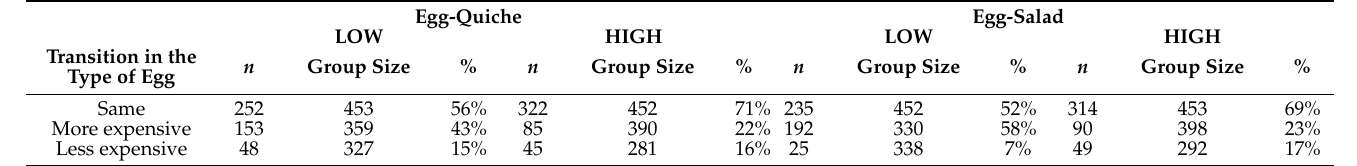
Table 5. Individual patterns of choices from fresh eggs to a quiche or a salad with